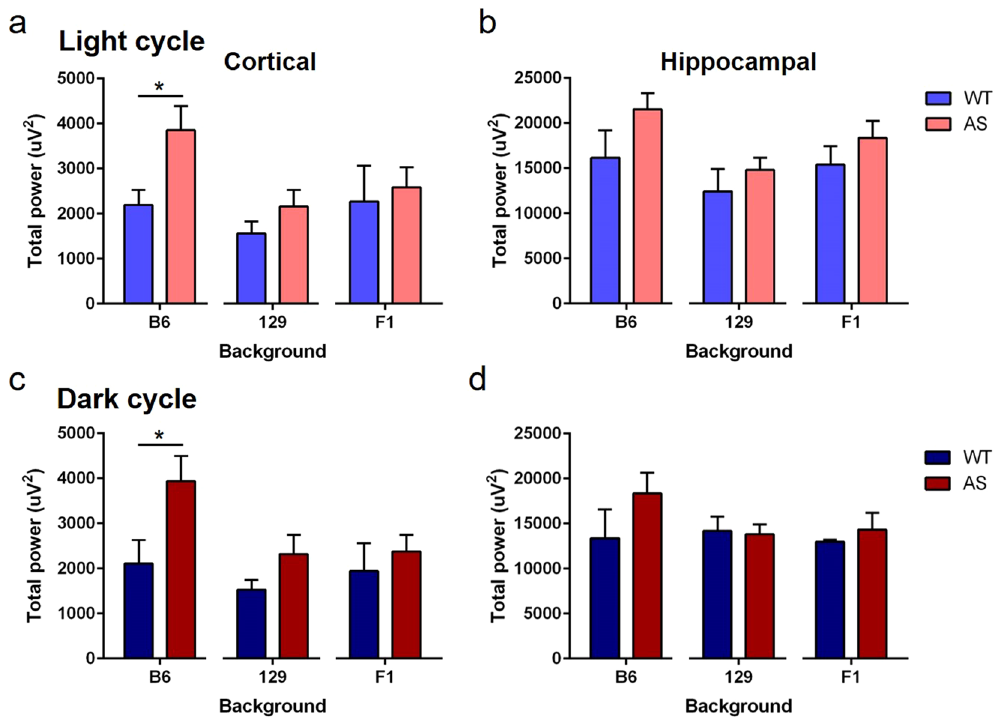
Figure 8. Total EEG spectral power in the cortex and hippocampus of Wt and AS mice on B6, 129, or F1 hybrid backgrounds. ( a , c ) Total EEG spectral power in cortex during the light ( a ) and dark ( c ) cycle was significantly increased in B6 AS mice compared to Wt controls (n = 9–11/group). No differences in total EEG spectral power between genotypes were observed in the recordings from cortex with 129 (n = 8–10/group) and F1 hybrid (n = 3–6/group) backgrounds. ( b,d ) Total EEG spectral power in hippocampus during the light ( b ) and dark ( d ) cycle was not significantly different in AS mice compared to the Wt controls for any strain. For each strain and time of day, Student’s t-test was used for analysis and data are presented as the mean ± SEM; * p <